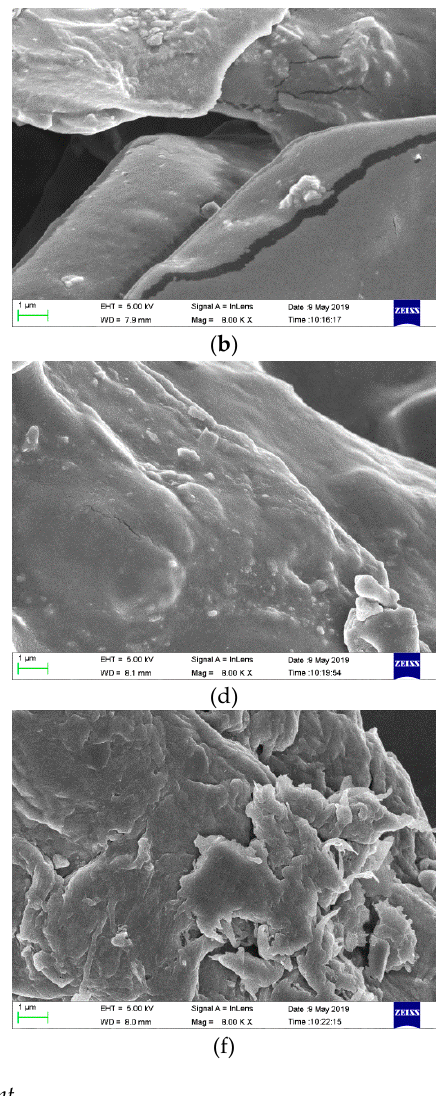
Figure 2. FT-IR spectra of SAF (Sodium alginate film), WEF (Sodium alginate incorporating water extract film) and EEF (Sodium alginate incorporating ethanolic extract